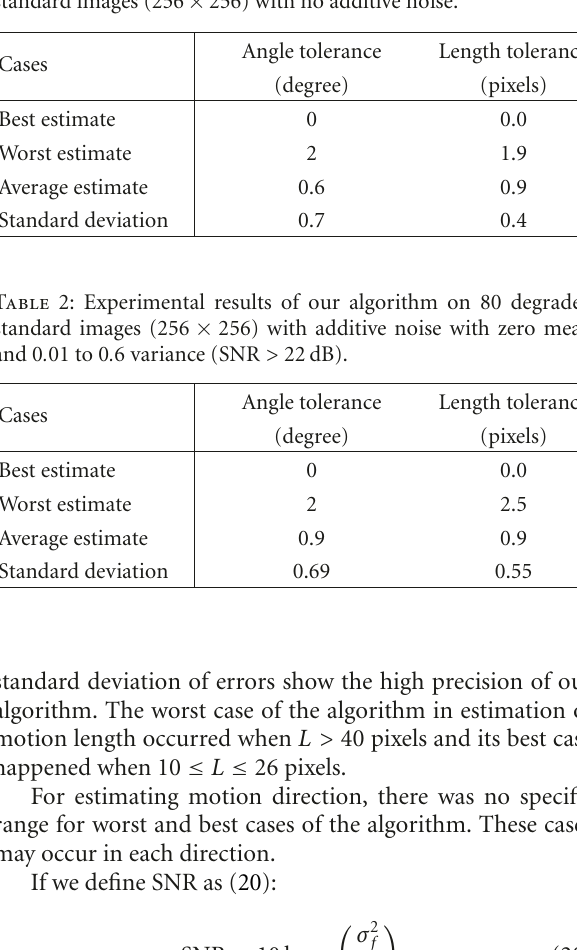
Figure 10: Baboon picture which was degraded by L = 10 pixels, φ = 135 ◦ and Gaussian additive noise (SNR = 25dB). Estimated values for this image using our algorithm were L = 8 pixels and φ = 136 . 8 ◦